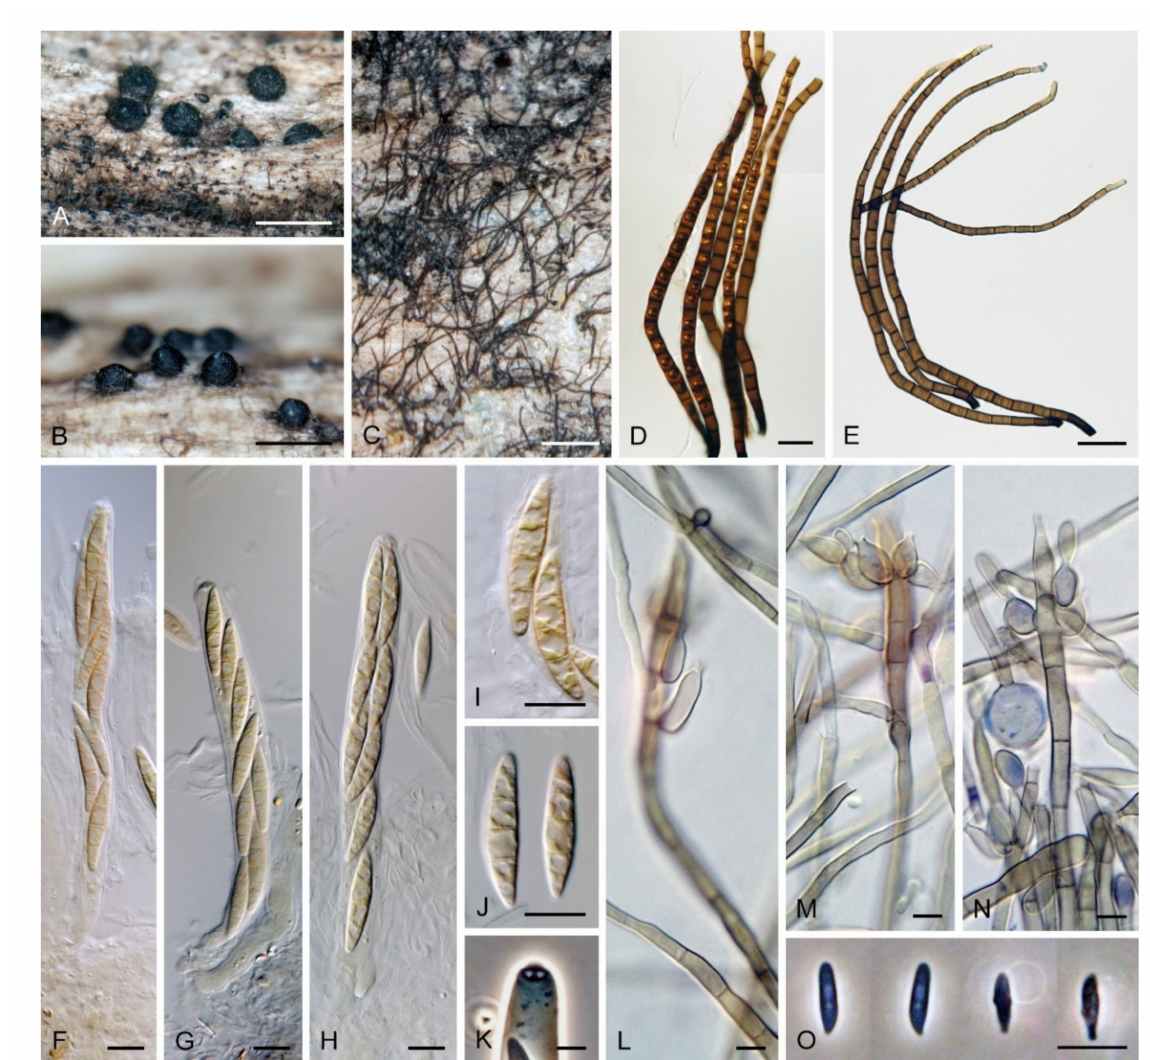
Figure 18. Zanclospora xylophila (ICMP 22737 ex-type). ( A , B ) Ascomata. ( C – E ) Stanjehughesia-like conidiophores. ( F – H ) Asci with ascospores. ( I , J ) Ascospores. ( K ) Ascal apex with an apical annulus. ( L – N ) Reduced Zanclospora conidiophores. ( O ) Microconidia. Images: ( A – D ) on the natural substrate; ( E – M ) on PCA after 8 weeks. Bars: ( A , B ) = 500 µ m; ( C ) = 250 µ m; ( D , L , M ) = 20 µ m; ( E – K ) = 10 µ